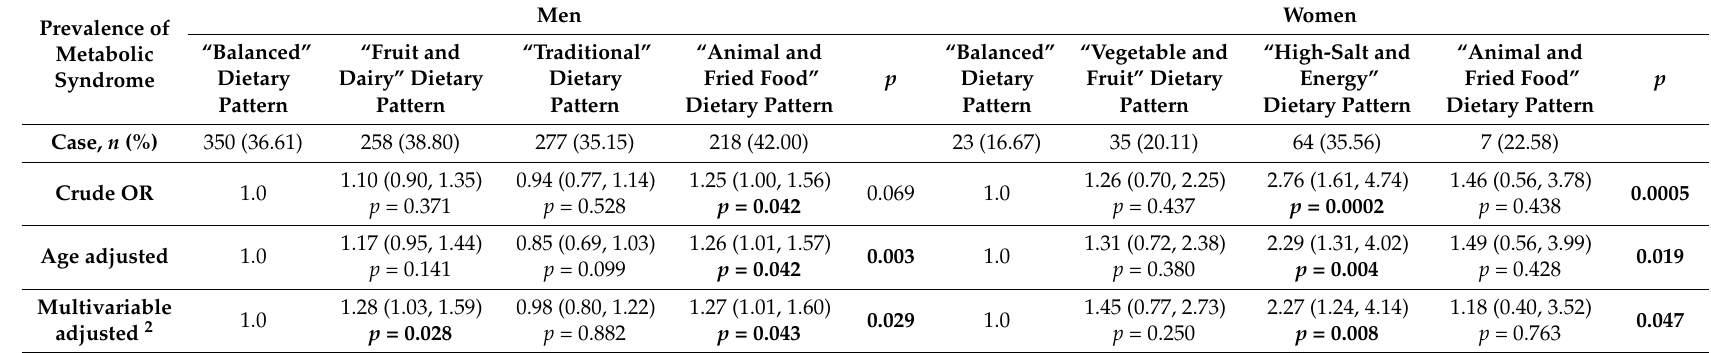
Table 8. Odds ratios (95% confidence intervals) of MetS according to dietary patterns 1 for men and